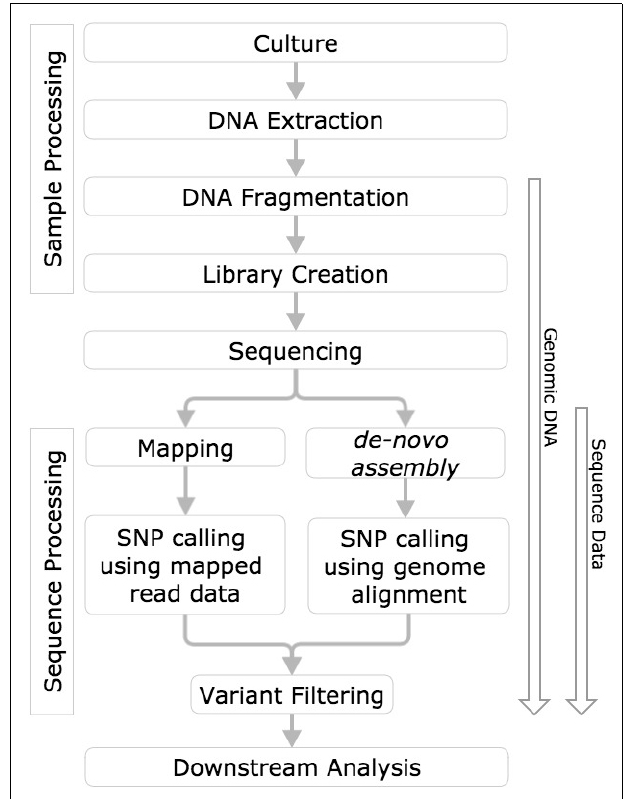
FIGURE 1 | SNP calling workflow diagram. Horizontal boxes represent steps in the workflow and arrows to the left indicate steps in the workflow challenged with reference genomic DNA, and sequence